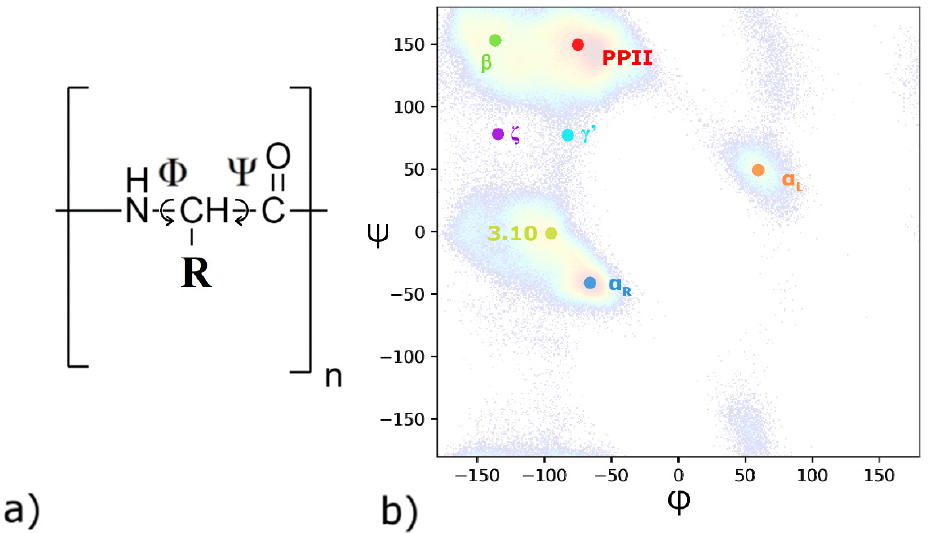
Figure 1. ( a ) Chemical structure of the PASA peptide. Rotations as defined by the torsion angles Φ and Ψ are indicated. ( b ) Ramachandran plot obtained using the CHARMM27 force field for PASA. Color code: green, 2.5 1 helix ( β -sheet); red, polyproline II helix (PPII); yellow, 3.10 helix; blue, right-handed α -helix ( α R ), orange, left-handed α -helix ( α L ); violet and cyan, ζ and γ ’ conformations, respectively.